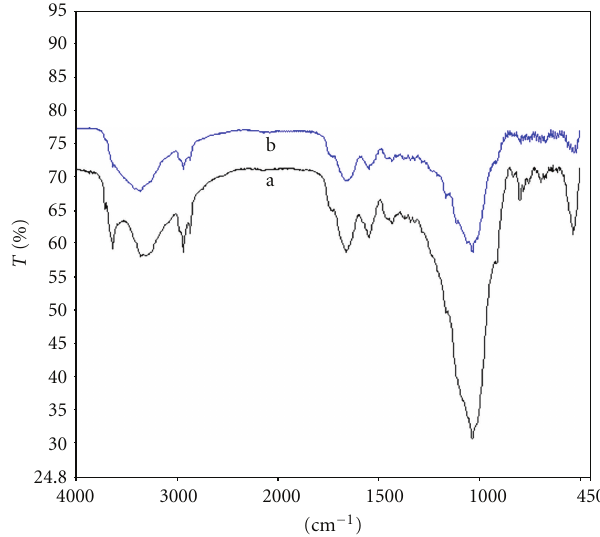
Figure 4: FTIR spectra of C. rivularis biomass: (a) native, (b) Pb (II)